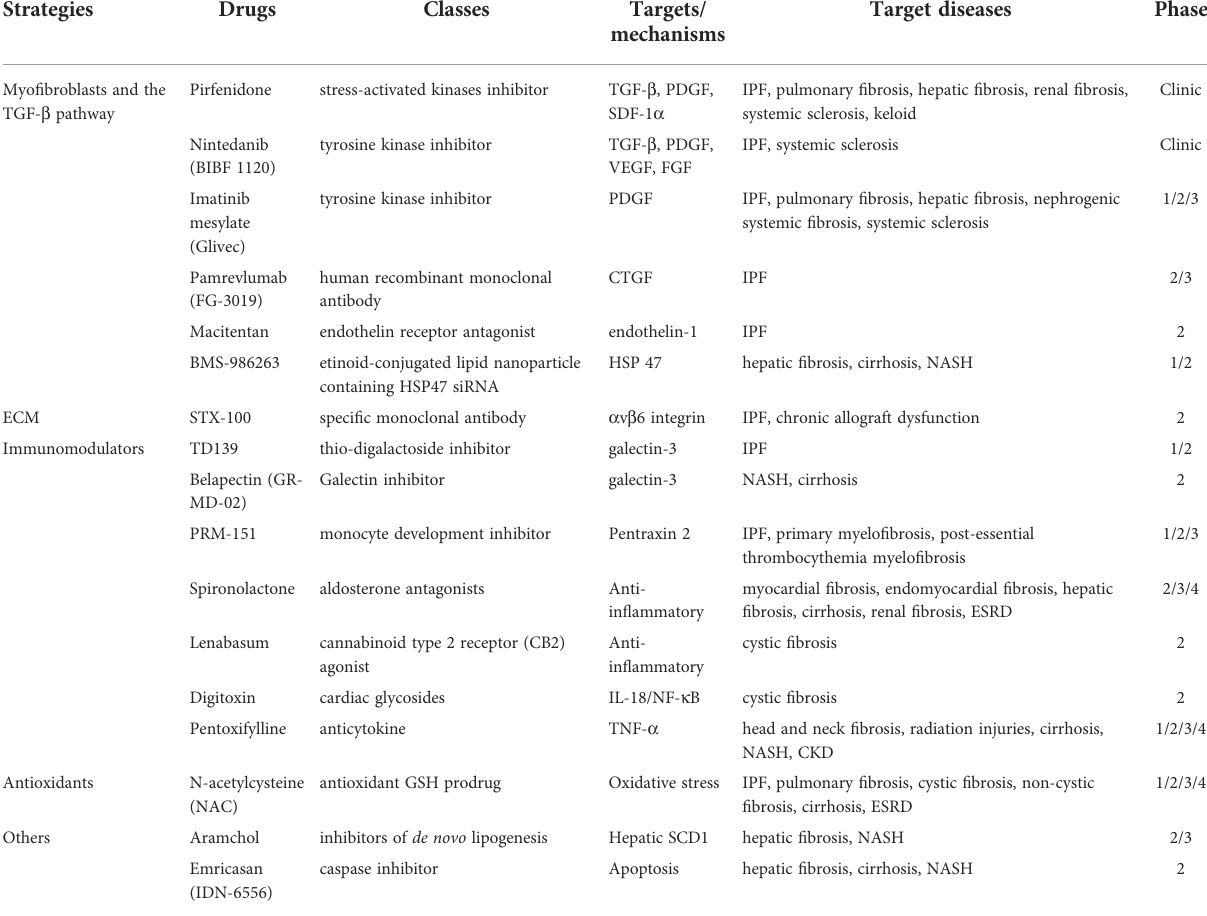
TABLE 1 Current anti- fi brotic strategies and drugs. Strategies